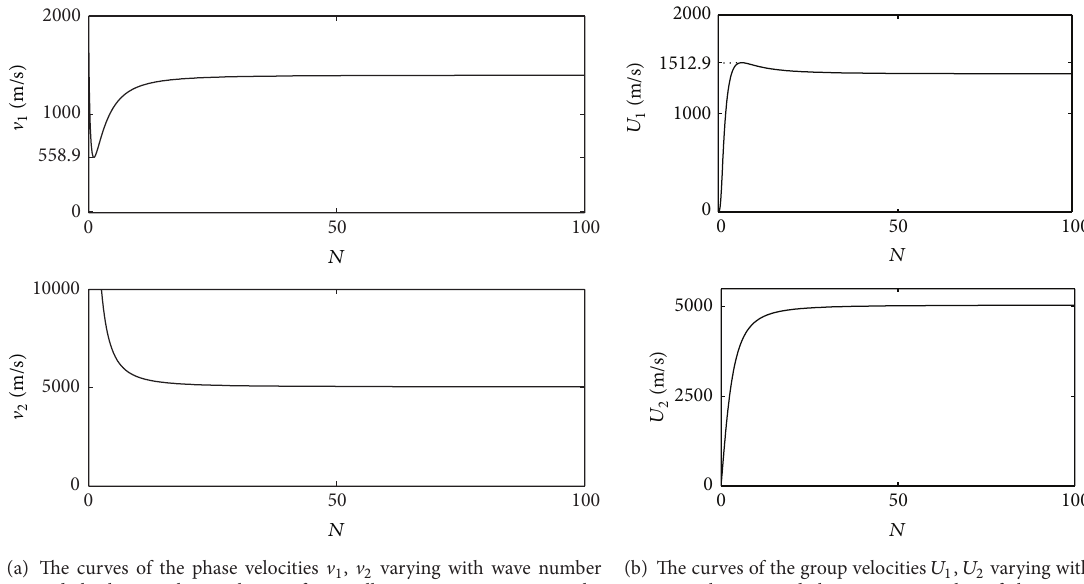
(b) The curves of the group velocities 𝑈 1 , 𝑈 2 varying with wave number 𝑁 , and the maximum value of the group velocity 𝑈 1 is 𝑈 1 max = 1512.9 m/s